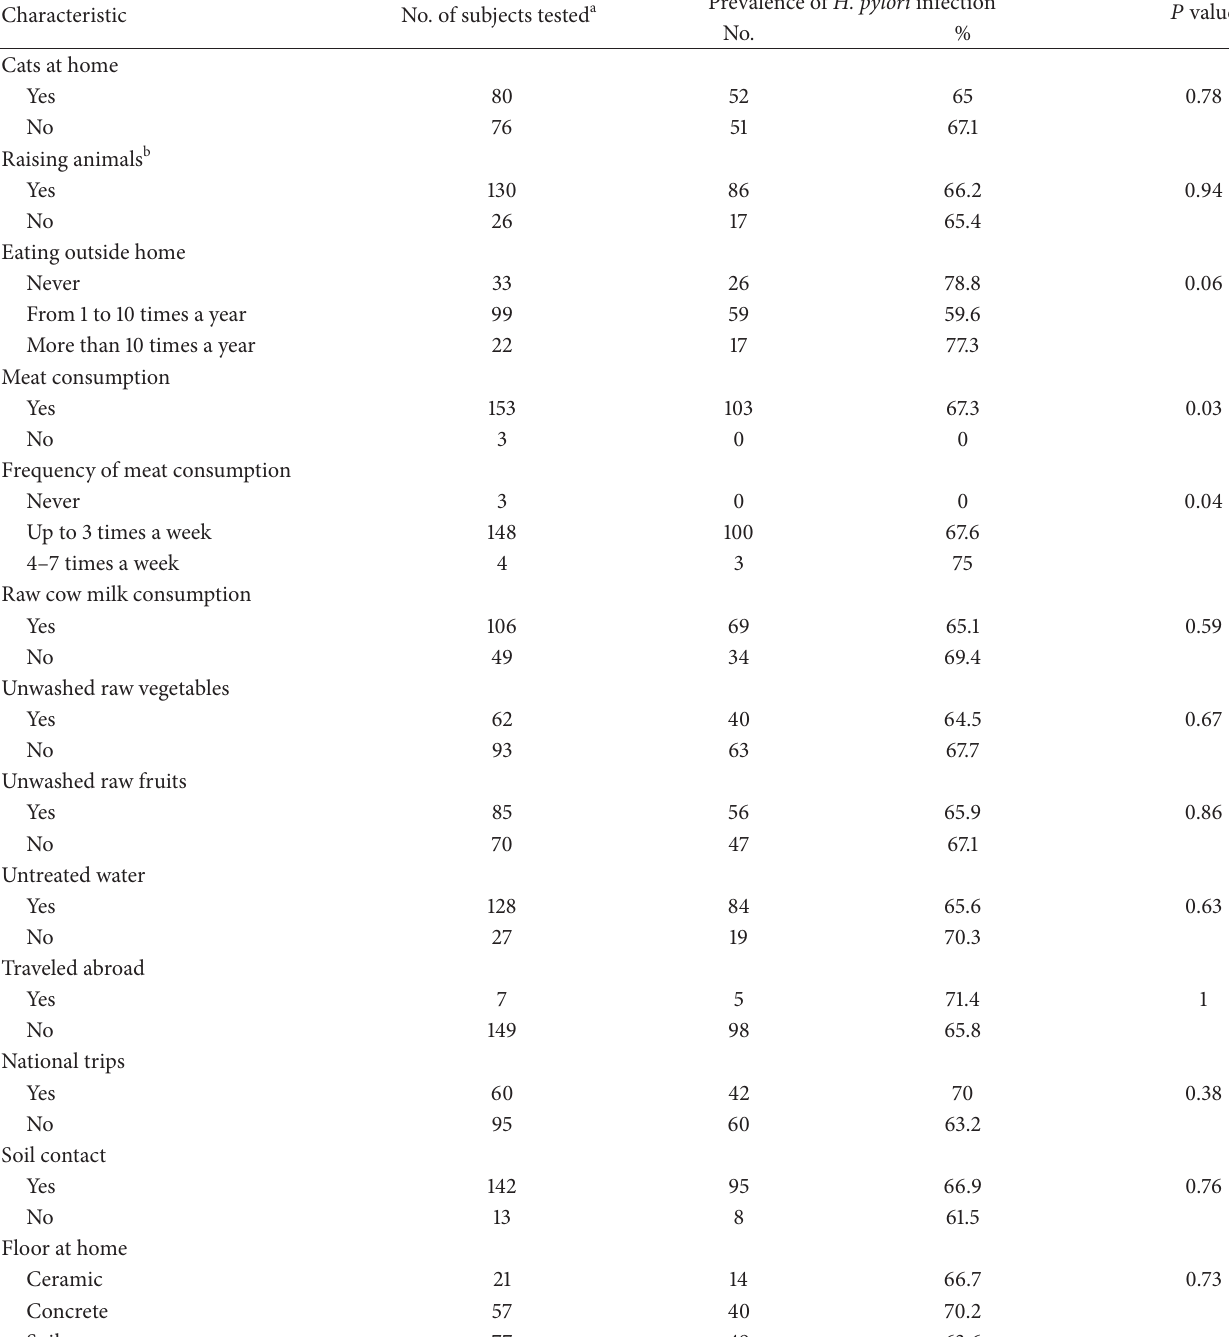
Table 2: Bivariate analysis of selected behavioral characteristics of Tepehuanos and seroprevalence of H. pylori infection. Characteristic No. of subjects tested a